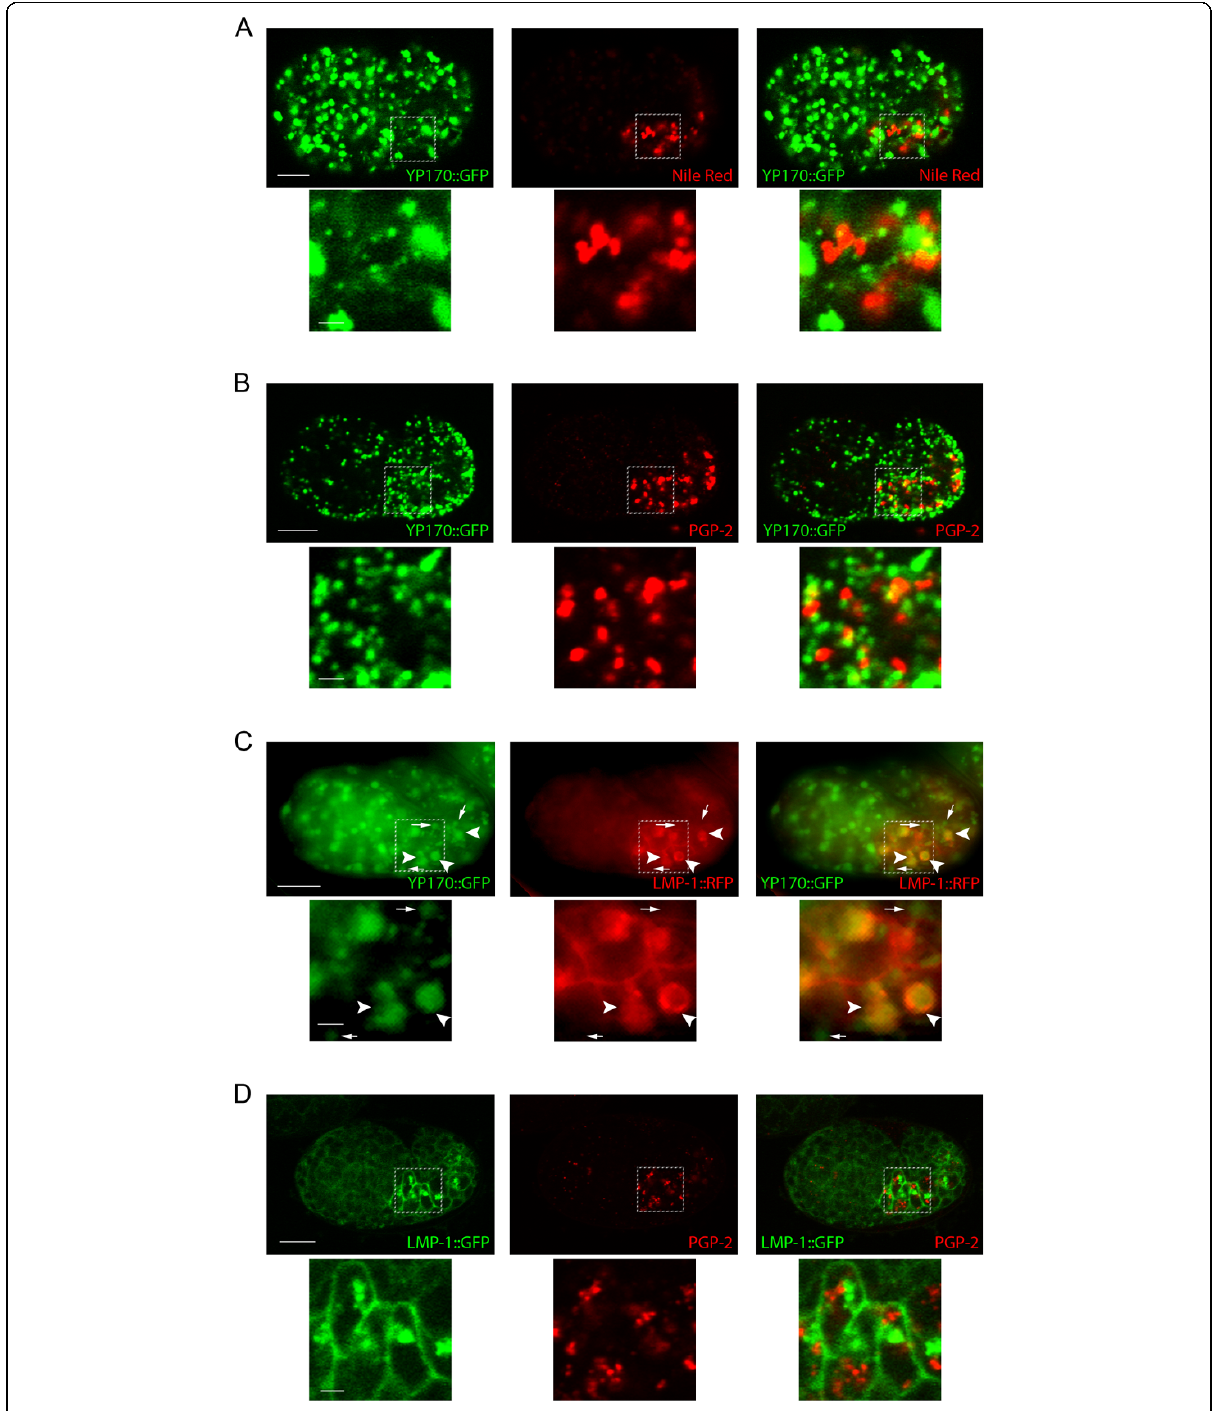
Figure 3 Late endocytic and lysosome-related organelles in developing intestinal cells of cup-5 mutant embryos . A) Confocal images of a cup-5(zu223) embryo that expresses YP170::GFP and stained with Nile Red. B) Confocal images of a cup-5(zu223) embryo that expresses YP170:: GFP and immunostained to detect PGP-2. C) Epifluorescence images of a cup-5(zu223) embryo that expresses YP170::GFP and LMP-1::TagRFP (S158T). Small arrows point to organelles containing only YP170::GFP; large arrowheads point to organelles containing both YP170::GFP and LMP- 1::TagRFP(S158T). D) Confocal images of a cup-5(zu223) embryo that expresses LMP-1::GFP and immunostained to detect PGP-2. Bottom panels are magnified images of the regions indicated in the top panels. Scale bars in whole embryo images represent 10 μ m; scale bars in magnified images represent 2 μ